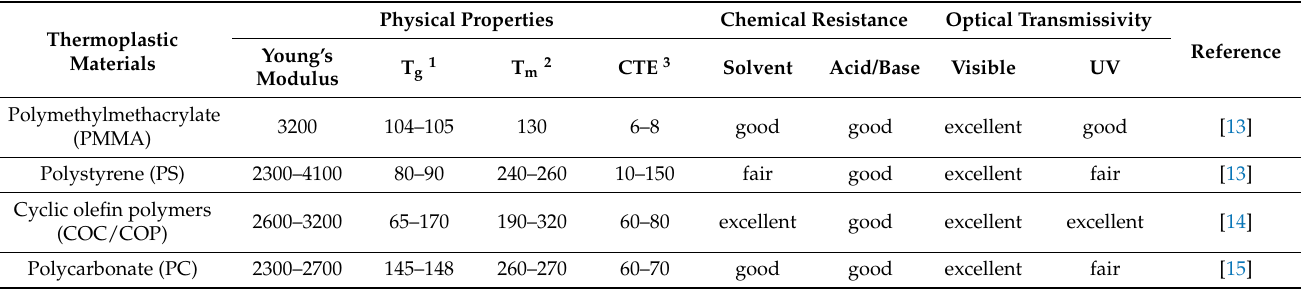
Table 1. Physical, chemical, and optical properties of commonly used thermoplastics in microfluid- ics.